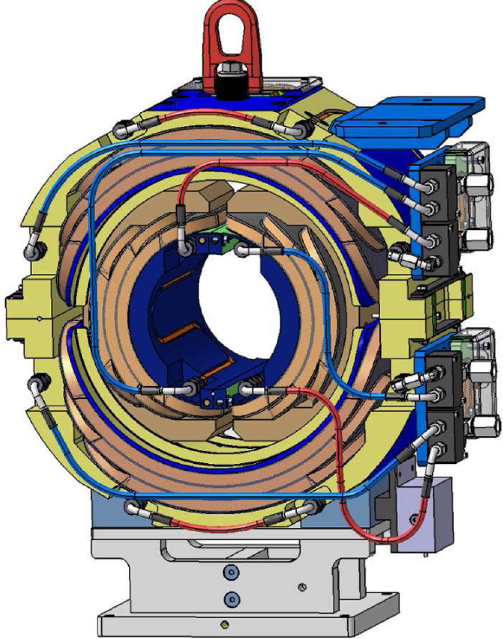
FIG. 15. Sketch of H = V corrector